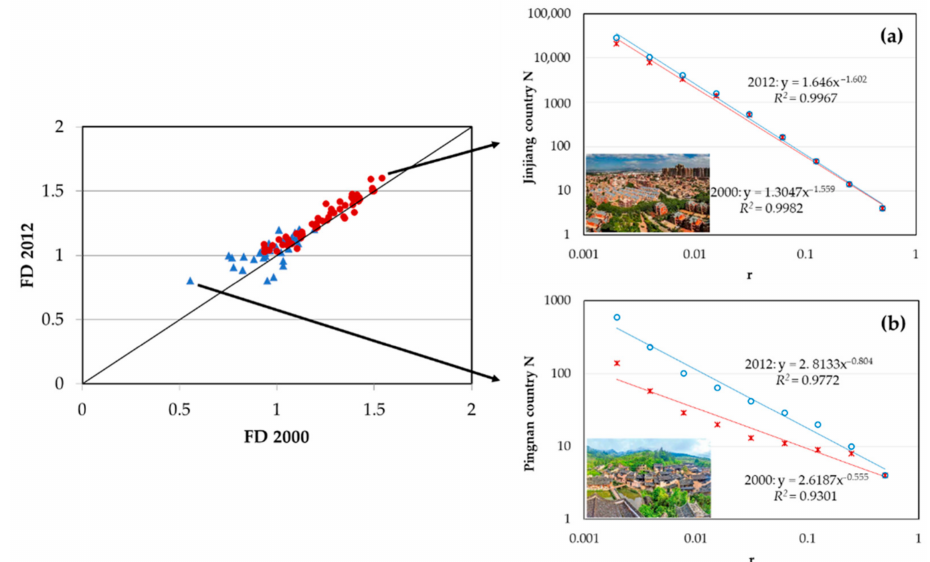
Figure 5. Fractal dimension values for 84 counties in 2000 and 2012; ( a ) log–log plots of the fractal dimensions of rural settlements in Jinjiang county; ( b ) log–log plots of the fractal dimensions of rural settlements in Pingnan county. FD: Fractal dimensions; x: 1/(2 r ); r: Iteration number; y = N: Box number with land